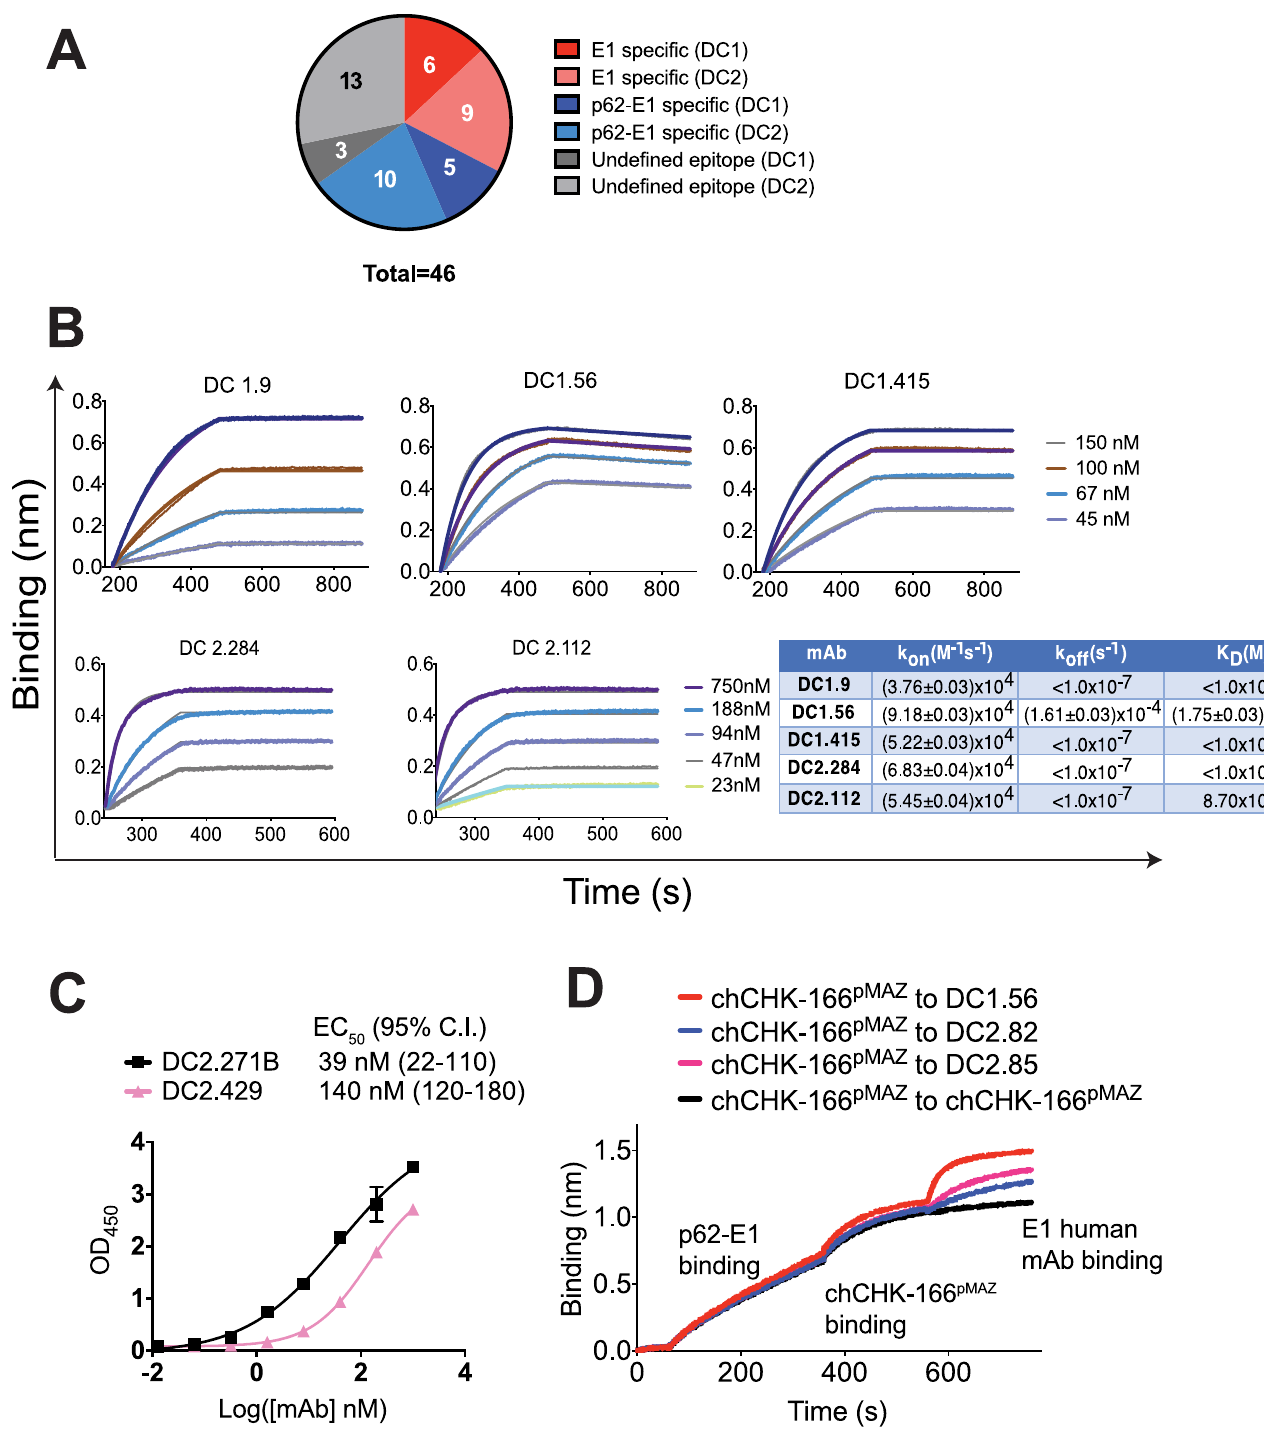
Fig 2. MAb binding profiles and epitope binning. ( A ) Distribution of specificities for mAbs isolated from DC1 and DC2, based on IP, ELISA and/or BLI studies. “p62-E1” specificity refers to mAbs that were confirmed to bind p62-E1 by ELISA and/or BLI, or that immunoprecipitated p62-E1 or E2. These mAbs likely have epitopes contained in E2 or shared epitopes across E1 and E2. “E1” specificity refers to mAbs that were confirmed to bind E1’ by ELISA and/or BLI. ( B ) Binding of E1-specific mAbs to E1’ by BLI. A representative dataset from two experiments is shown. ( C ) Full ELISA binding curves for DC2.271B and DC2.429 against p62-E1; a representative dataset from two experiments each performed in triplicate is shown (points represent mean ± SD). ( D ) Two-phase binding by BLI of E1 mAbs DC1.56, DC2.82, and DC2.85 against E1 mAb chCHK-166 pMAZ . In all cases, the human mAbs were able to engage p62-E1 simultaneously as CHK-166, regardless of order of addition, thus indicating that they do not share epitopes with CHK-166. A representative dataset from two experiments is shown.